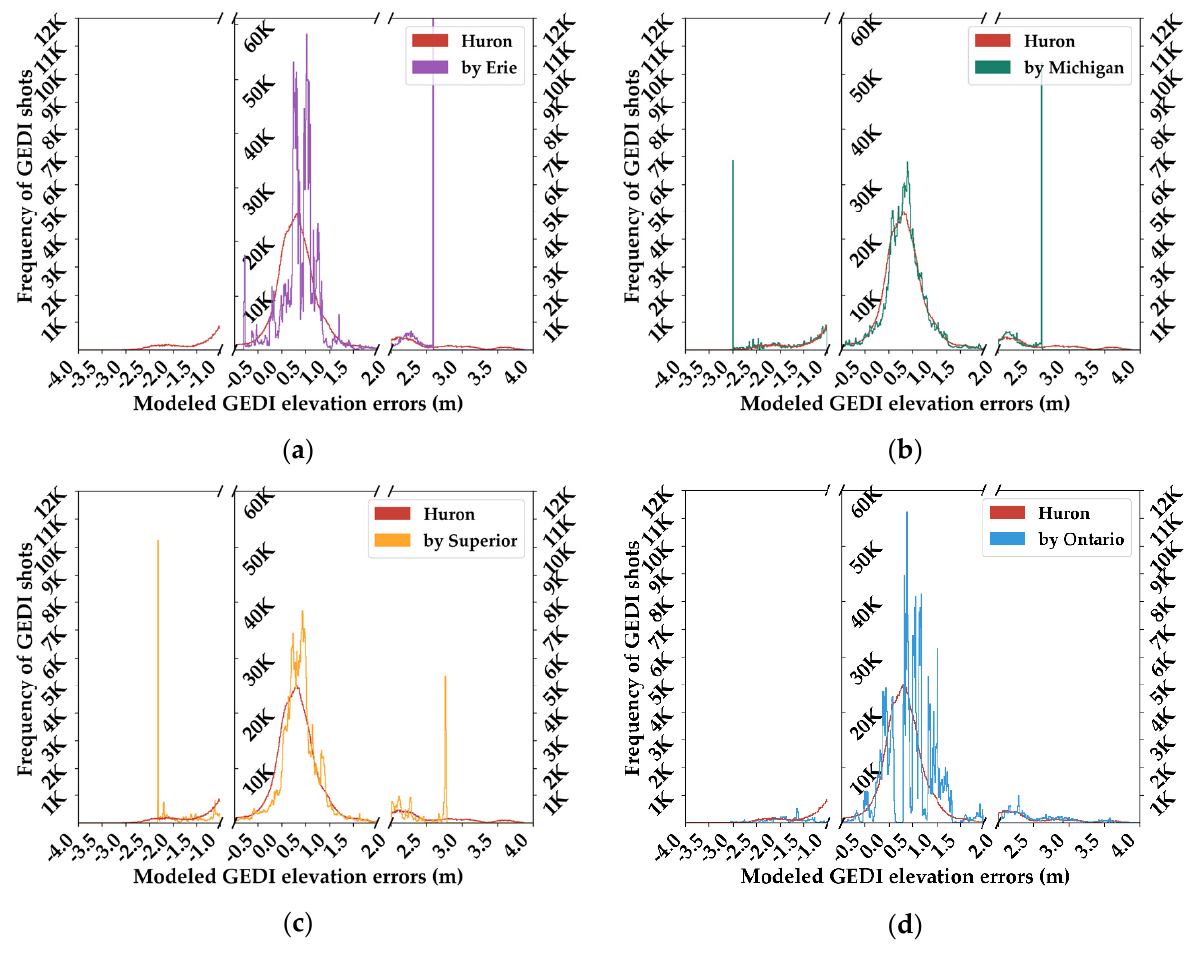
Figure 14. Distribution of the modeled GEDI elevation errors over Lake Huron (red histogram) after the application of the RF ICW model trained over Lake Erie ( a ), Michigan ( b ), Superior ( c ), and Ontario ( d ).